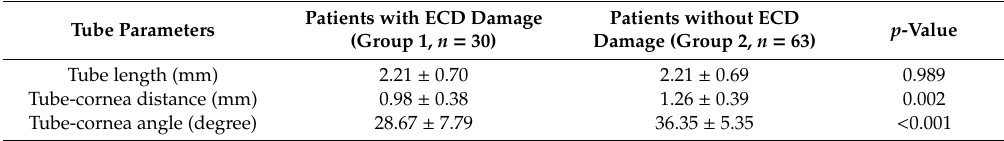
Table 2. Tube parameters measured by anterior segment optical coherence tomography (AS-OCT). Patients with ECD Damage Tube Parameters (Group 1, n = 30)